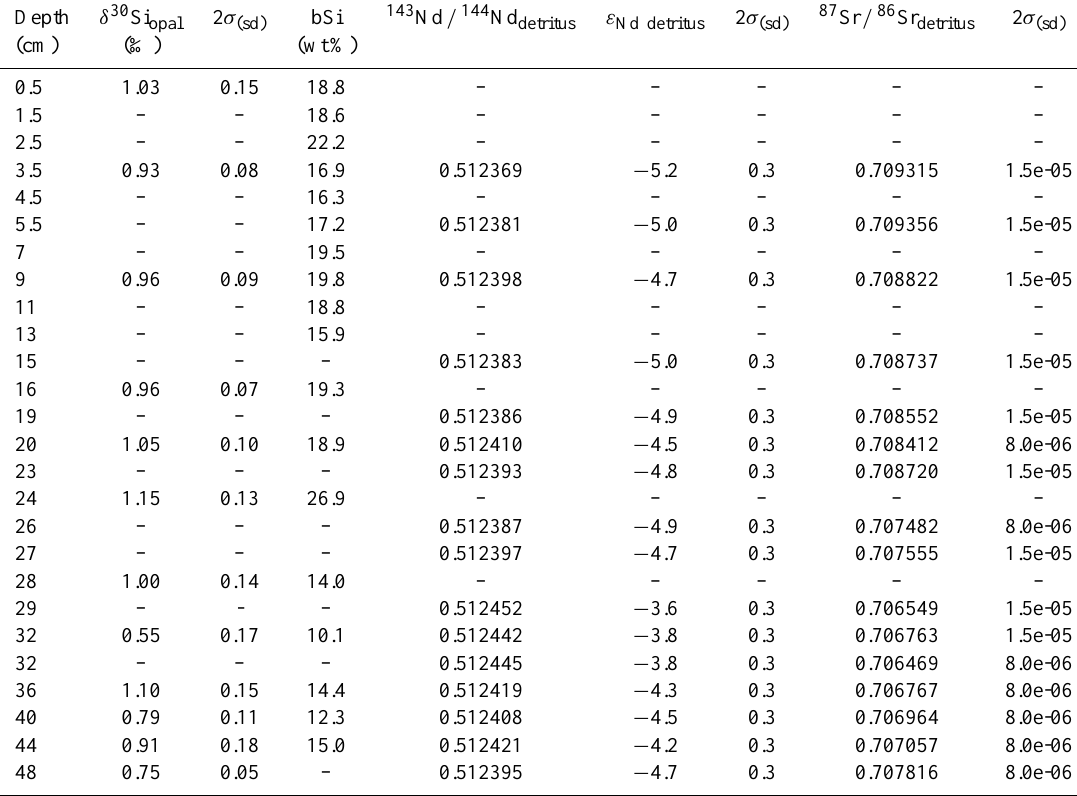
Table 1. Downcore records of core M771-470 for δ 30 Si opal (‰); bSi content (wt%); and 143 Nd/ 144 Nd, ε Nd and 87 Sr / 86 Sr of detrital material. 2 σ (sd) represents the external reproducibilities of repeated sample (Si) and standard (Nd, Sr) measurements. Depth